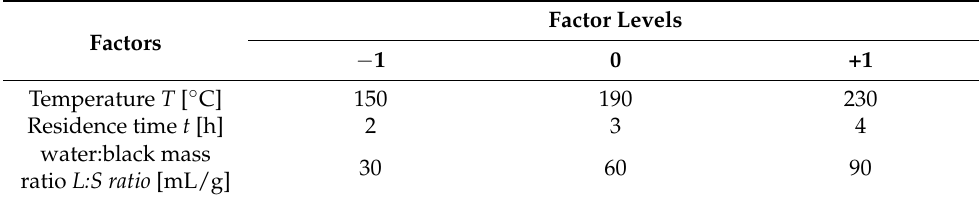
Table 1. Factors and levels in the 3 3 Box-Behnken experimental